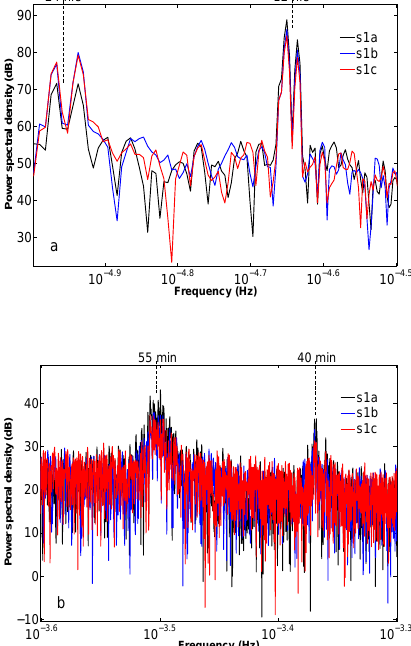
Figure 6. Power spectral densities of the strain components at MOK (colorcoded). (a)Zoomatlowfrequencyonthediurnaland semi-diurnal frequency band. The related peaks of solid and oceanic tides dominate the spectra. The s1b and s1c components are 2 times more sensitive to 24-hours period tides than s1a whereas s1c seems to be a little less